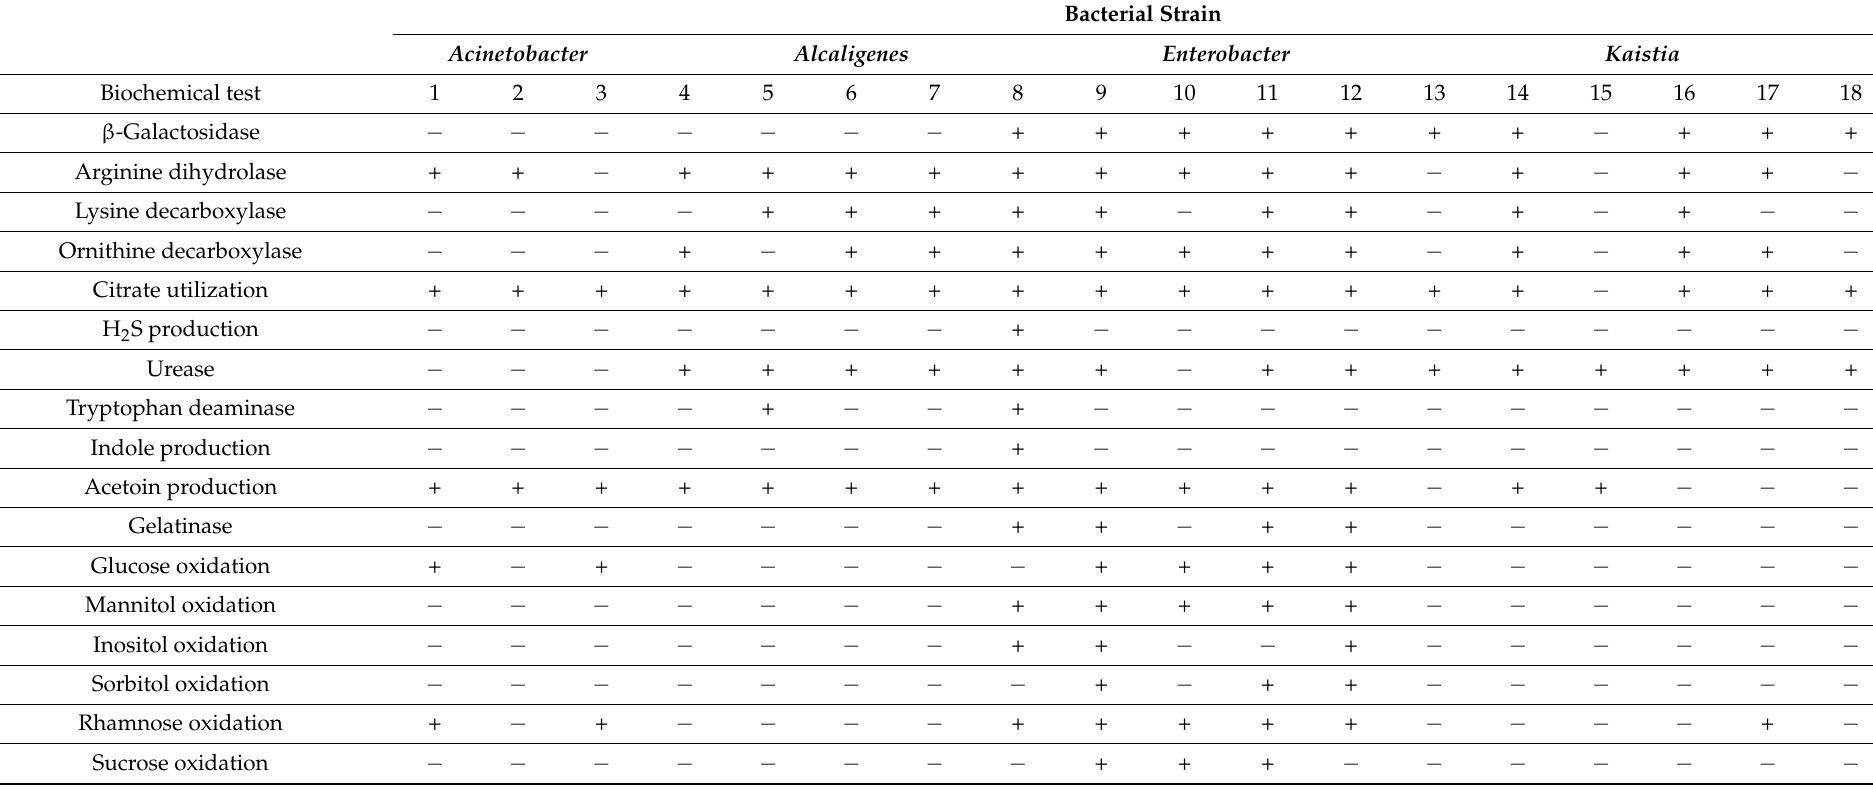
Table 5. Phenotypic characters of the different strains described in this study and of the type strains of closely related species. 1: Acinetobacter bereziniae DSM 25435 T